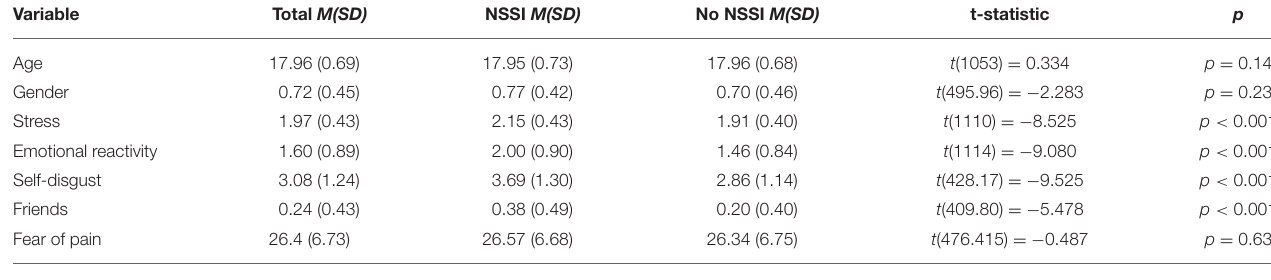
TABLE 3 | Mean differences between NSSI and no NSSI groups on study measures at Time 1.